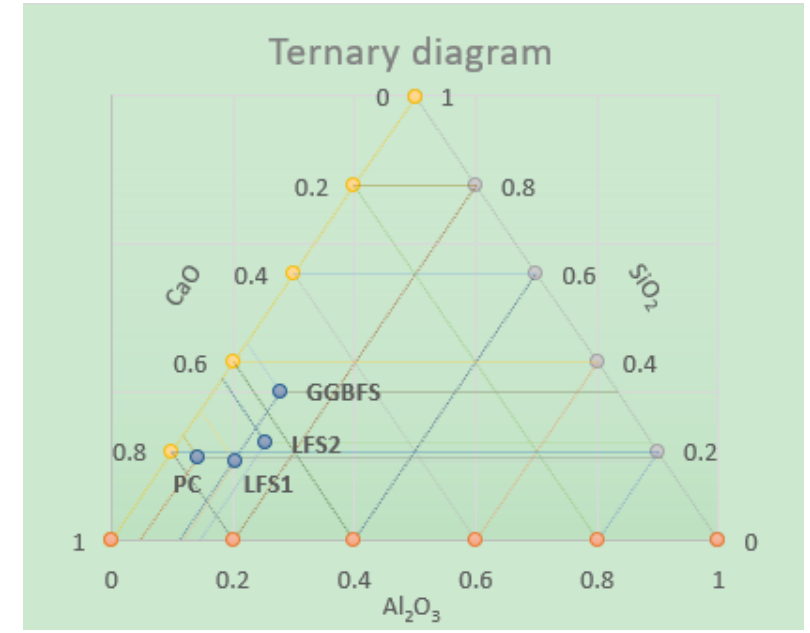
Figure 1. Ternary diagram indicating the compositions of Portland cement (PC), ground